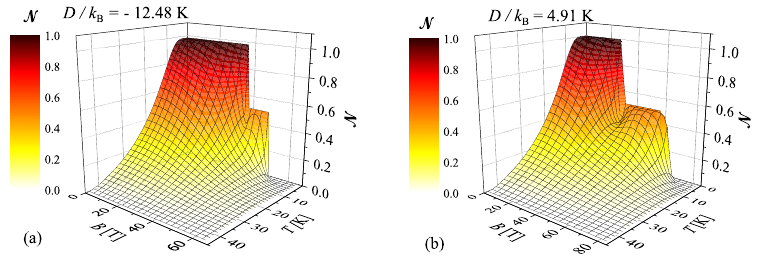
Figure 8. The negativity of the NAOC complex in the form of 3D plot versus temperature and magnetic field. The relevant theoretical predictions are based on the spin-1 Heisenberg dimer (1) with the isotropic coupling constant J / k B = 30.66 K and ∆ = 1 by considering two different spatial orientations of the magnetic field applied either along to the crystallographic c ∗ - or a -axis: ( a ) D c ∗ / k B = − 12.48 K, g c ∗ = 2.28; ( b ) D a / k B = 4.91 K, g a =